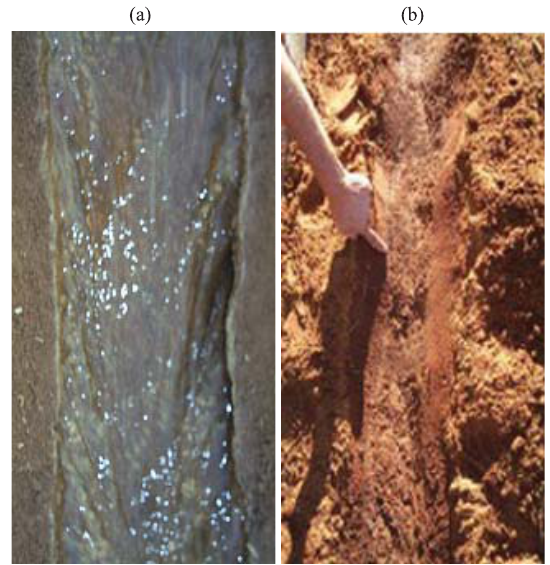
Figura 2. Desmoronamento das paredes laterais do sulco durante a aplicação do teste (a) e desnível formado no leito do sulco (b) em um Cambissolo Háplico textura média do semiárido.